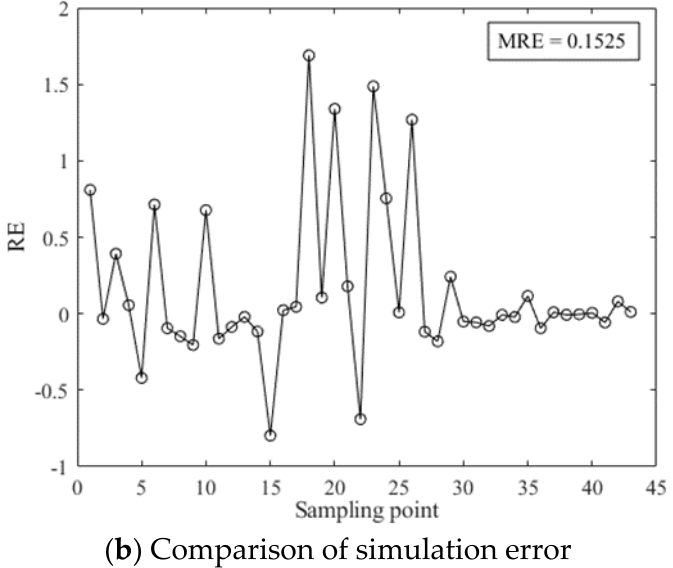
Figure 3. The performance comparison and analysis of the Col-SVM model at each sampling point.